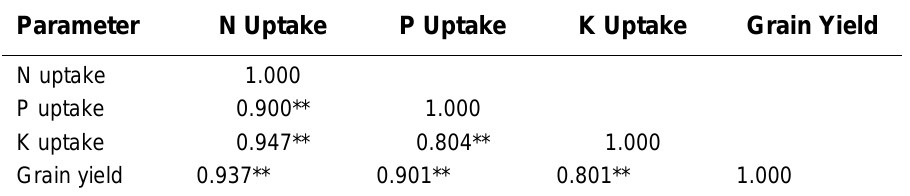
Simple Correlation Matrix Showing the Relationship of Observed N, P, and K Uptake by Wheat with Grain Yield